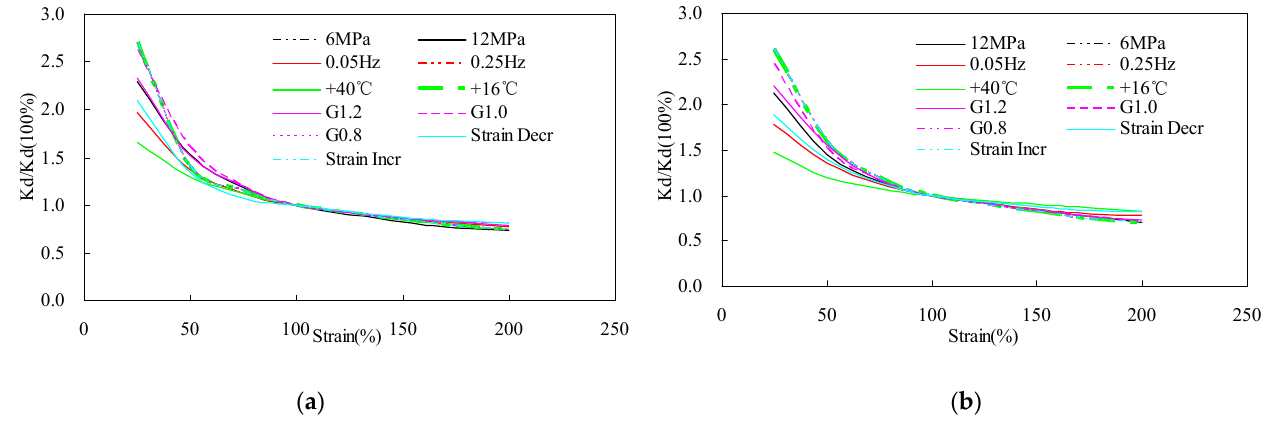
K Figure 4. The mechanic properties K d of the bearings under different conditions: ( a ) LRB; ( b ) Figure 4. The mechanic properties d of the bearings under different conditions: ( a ) LRB; ( b ) SHDR.